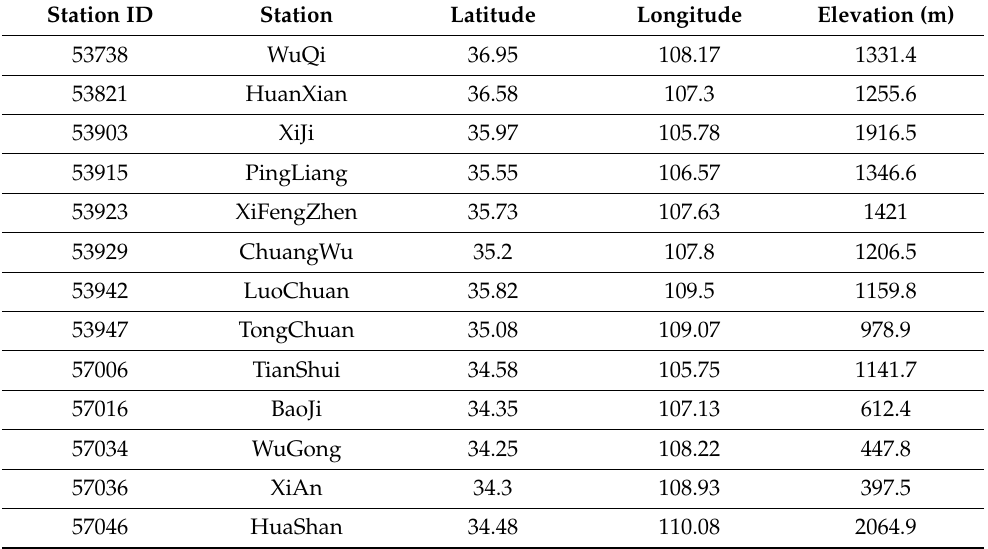
Table 1. Meteorological stations used in this